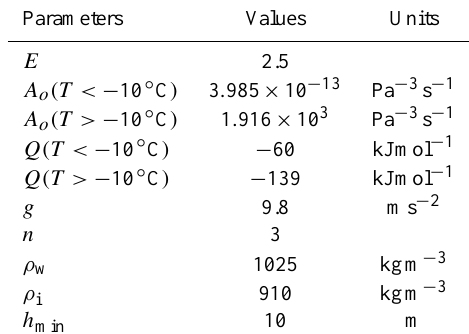
Table 1. List of parameter values used in this